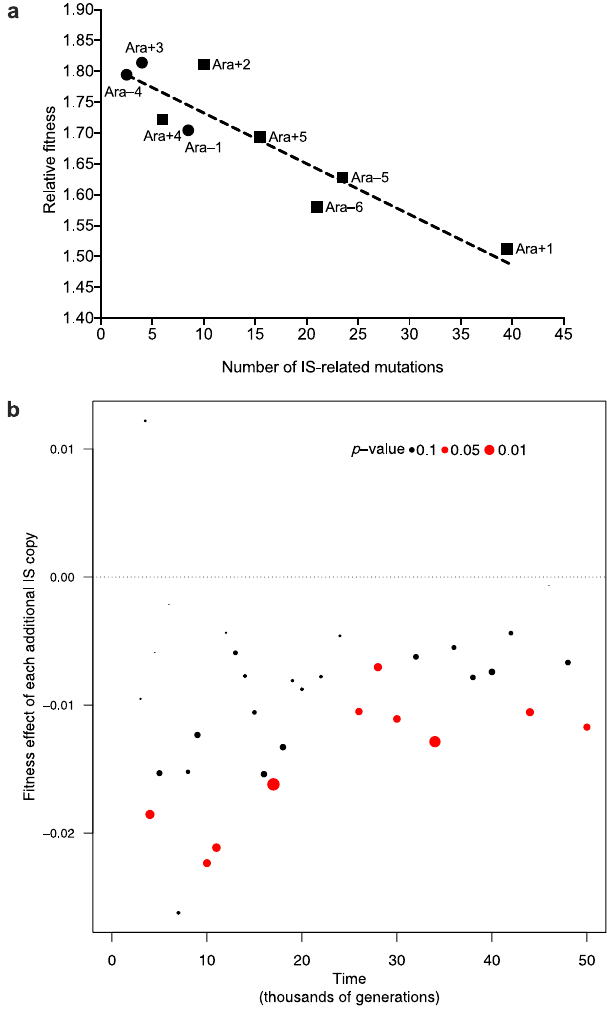
Fig. 5 Relationship between fi tness and IS-related mutations. a Mean fi tness of evolved populations at 50,000 generations, relative to the common ancestor, as a function of the number of IS-related mutations. The number of IS-related mutations uses the average value of the two evolved clones sequenced at that time point. Fitness values are inferred from a power-law model according to Wiser et al. 13 . Three populations (Ara – 2, Ara – 3, and Ara + 6) are excluded owing to technical problems associated with measuring their fi tness values 13 . Circles and squares indicate mutator and non-mutator populations, respectively. The line shows the least- squares linear regression y = 1.813 − 0.0081 x ( n = 9, r = – 0.9115, two- tailed p = 0.0006). b Multiple regression analysis to estimate the marginal fi tness effect (the cost, when negative) associated with having an extra IS copy, taking into account the lineage ’ s mutator or non-mutator status over time. The size of the points is larger for lower p values; red points indicate a signi fi cant contribution of IS copy number to fi tness at the 5% level. Source data are provided as a Source Data fi